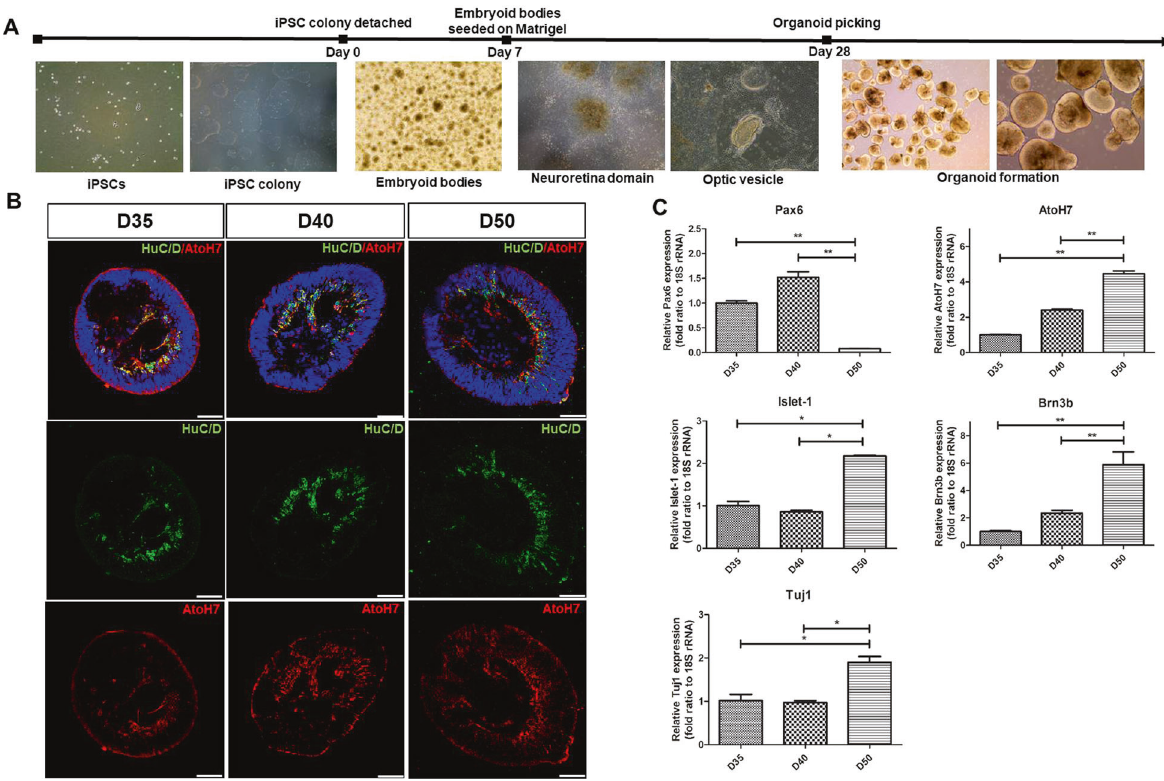
Fig. 1 Formation of hiPSC-derived ROs and RGC development at an early stage. A Main steps of hiPSC-derived RO development in vitro: hiPSC colony, EB formation, neuroretinal domain, and ROs. B Immuno fl uorescence staining of HuC/D (green) and AtoH7 (red) of ROs at distinct differentiated time points. The expression of HuC/D and AtoH7 was gradually increased in the innermost layers of ROs from day 35 to day 60. C Quantitative RT-PCR results of PAX6, AtoH7, Islet-1, Brn3b, and Tuj1 levels of ROs at indicated time points. Data are expressed by mean ± S.E.M. * p < 0.05, ** p < 0.01 by the Kruskal – Wallis test with post hoc analysis. Scale bar, 50 μ